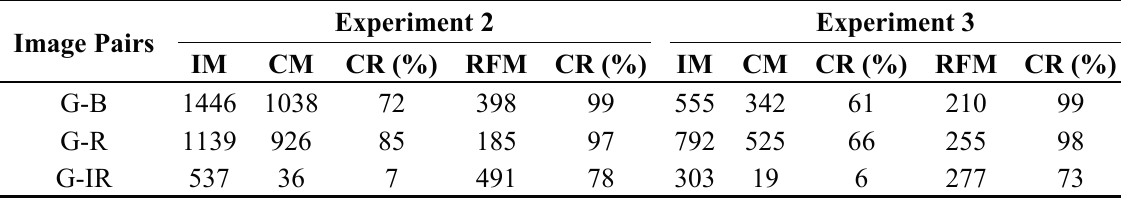
( left ) ( right ) Figure 7. Image registration; ( left ) the result obtained by using the RANSAC directly; ( right ) the result obtained by using our method. Table 1. The number of matches and correct